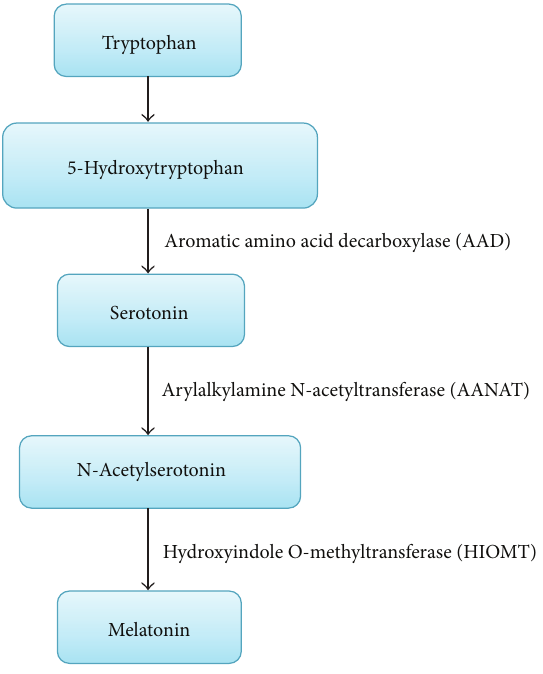
Figure 1: Biochemical synthesis of melatonin. Tryptophan acts as a precursor for melatonin synthesis. AAD is responsible for the conversion of 5-hydroxytryptophan into serotonin. Melatonin is formed from serotonin through a phase of reaction with the help of two enzymes, AANAT and HIOMT. Acetylation of serotonin occurs with the action of AANAT which forms N-acetylserotonin and subsequently HIOMT converts N-acetylserotonin into